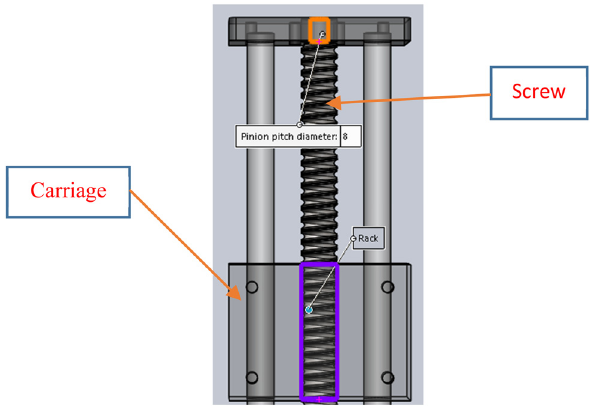
Figure 5: Translational motion between carriage and